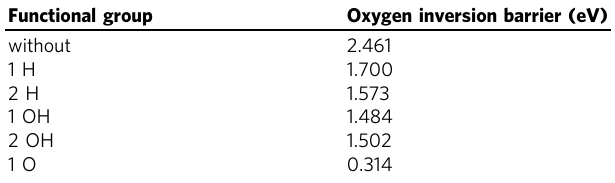
Table 1 Calculated inversion barrier of an oxygen atom at a SW defect through free-standing graphene as a function of the types of attached functional groups Functional